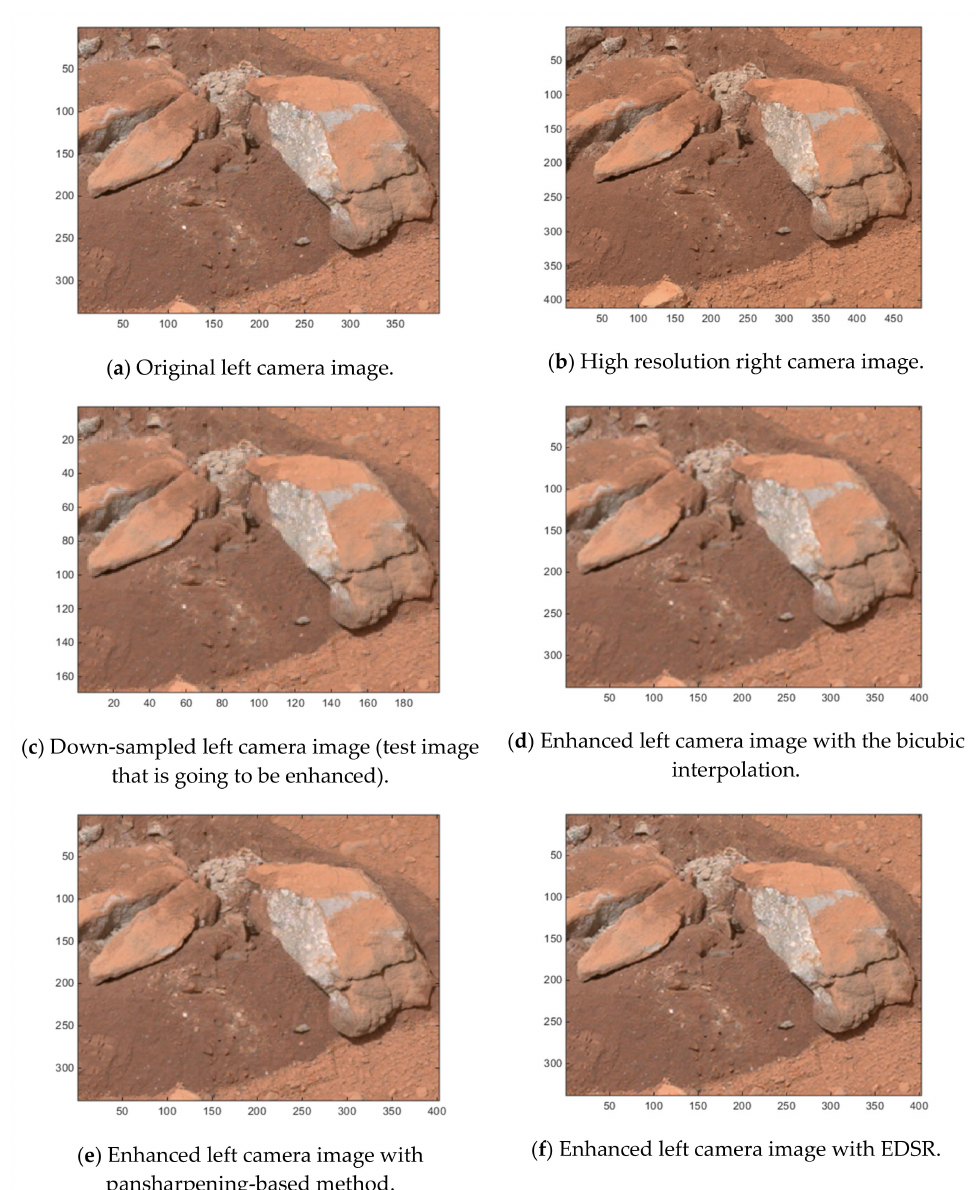
Figure 17. Mastcam image pair 6 (Sol 174) and the left camera image enhancements with the three